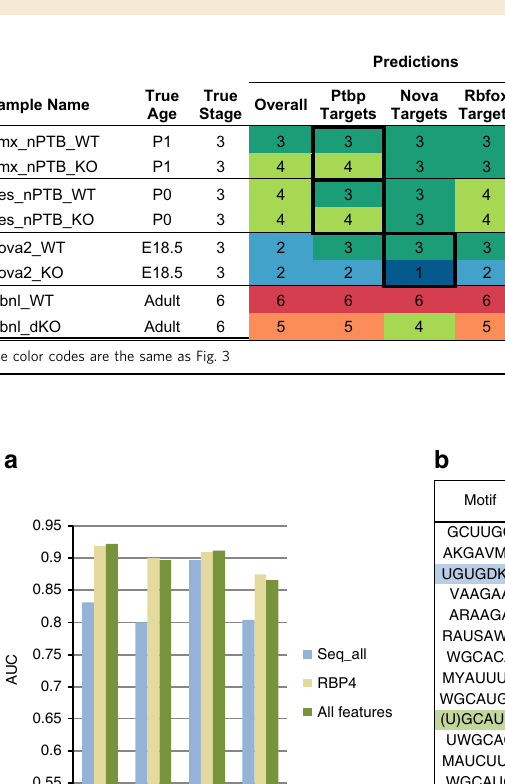
Table 1 Predicted maturation stages of WT and RBP KO brains using the overall splicing pro fi le or exons regulated by speci fi c RBPs